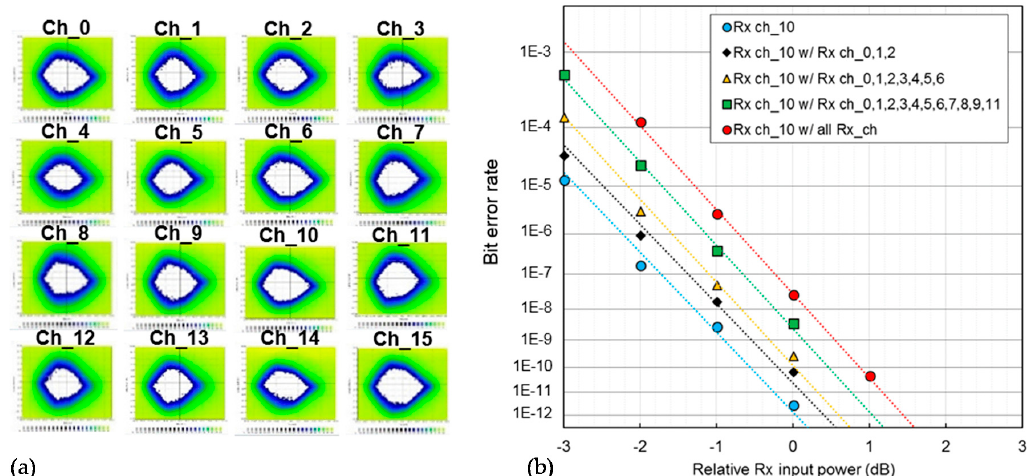
Figure 13. ( a ) Optical eye diagrams of all receiver channels and ( b ) BER performance under the first channel; TX: trans- mitter; Rx: receiver; (From [28] © 2021 IEEE).